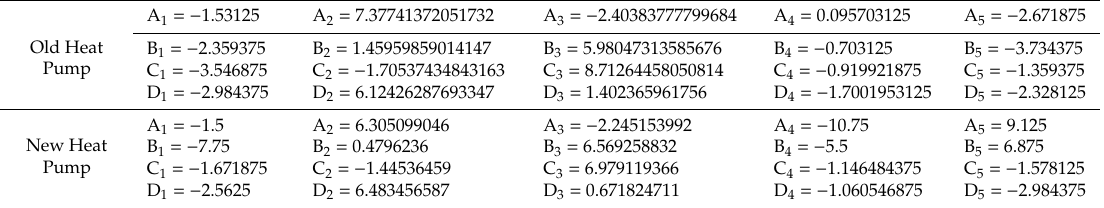
Table 2. Coe ffi cients for the water-to-water heat pump models.